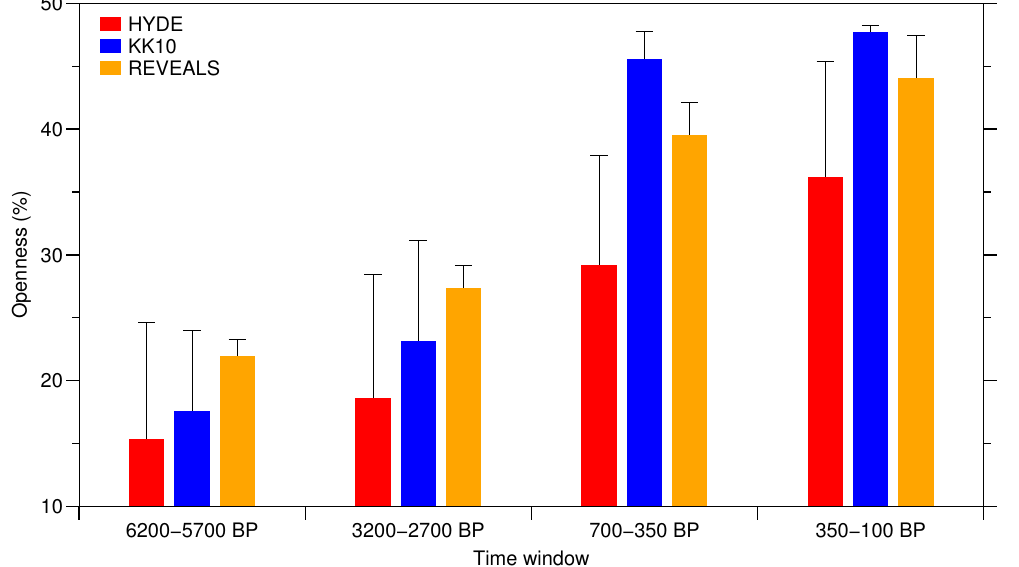
Figure 6. Percent open land (non-forested) within the study area for KK10 and HYDE modeled land use and the REVEALS reconstructions. Total open areas were summed and divided by the total area of the grid cells with REVEALS data for each time